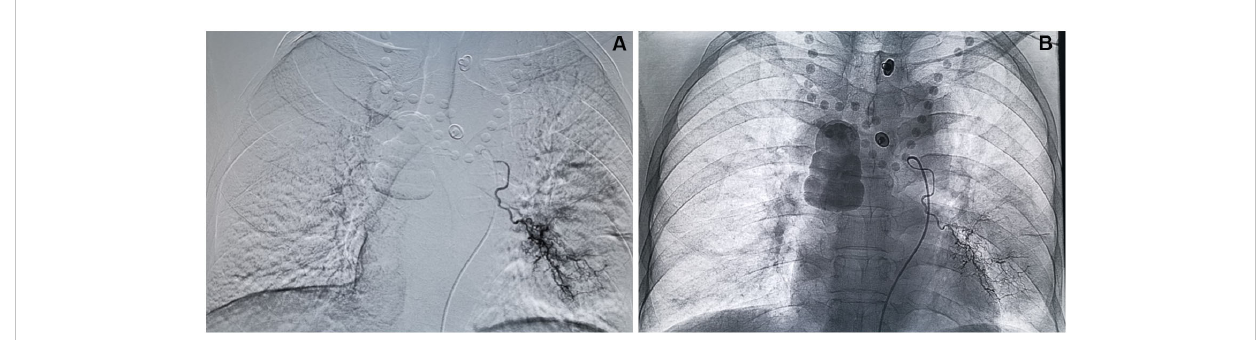
FIGURE 3 Process of DEB-BACE. (A) Superselective angiography shows hyperplasia and distortion of tumor vessels and fl aky tumor staining in the left lower lung region. (B) Angiography after DEB-BACE shows the presence of main and branches of the left bronchial artery, and the tumor vessels and tumor staining basically disappeared.